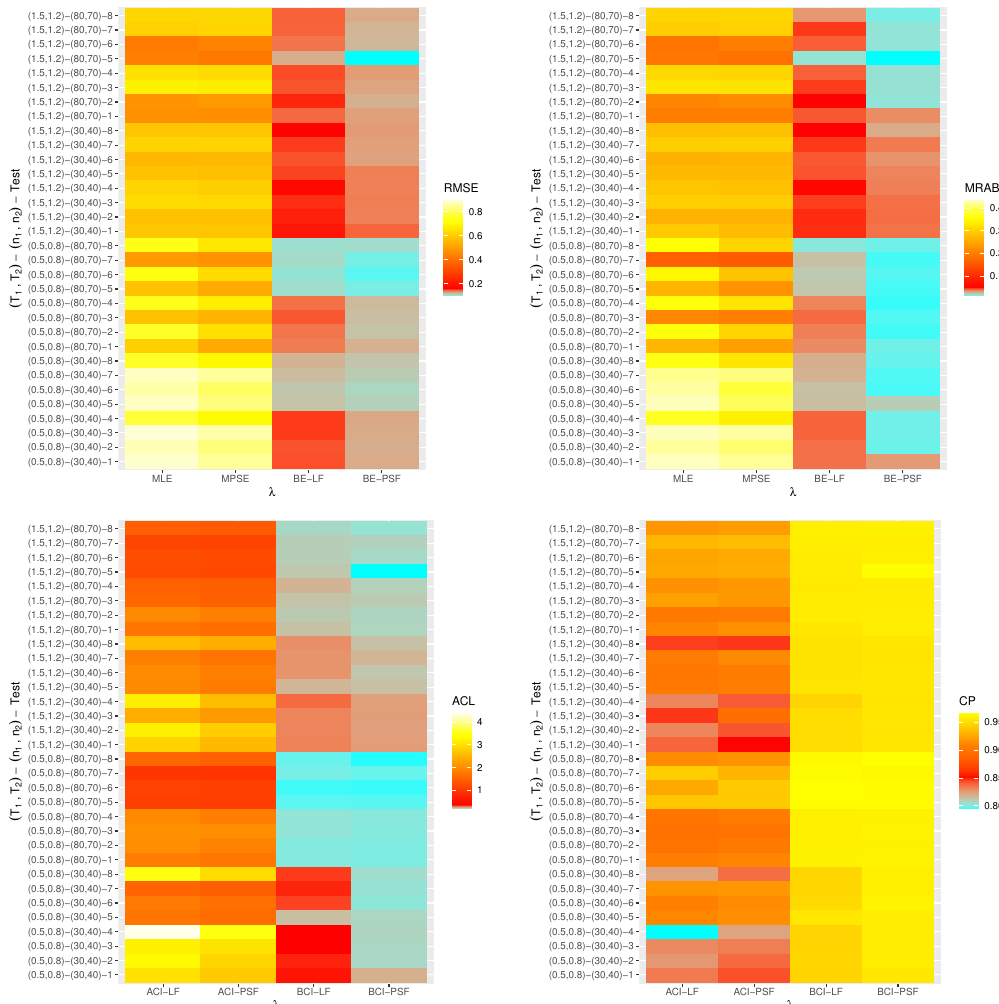
Figure 8. Heatmap for the estimation results of λ using Set